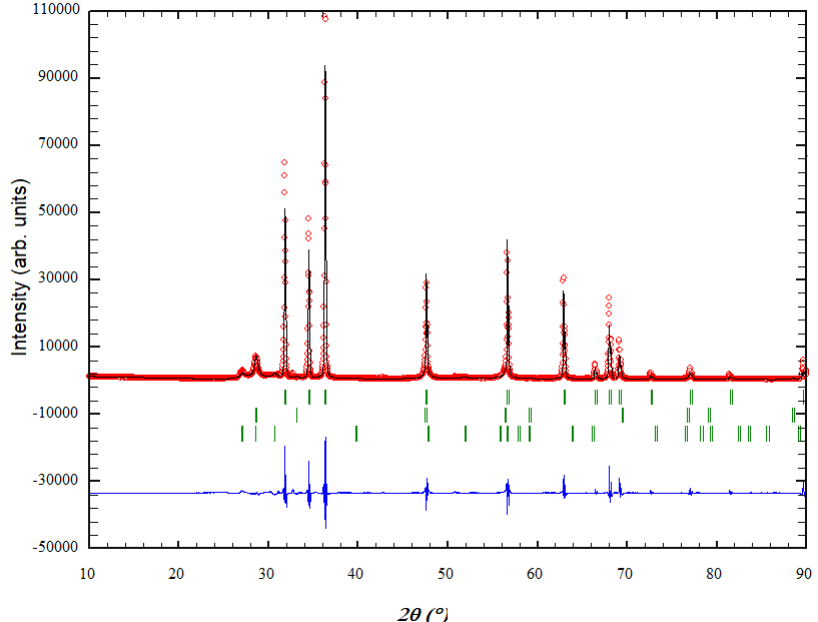
Figure 1. Rietveld diagram of ZnO/ZnS powders obtained after heating at 400 °C for 6 h. The blue line denotes the difference between the experimental (red diamonds) and theoretical (black line) profile, while the Bragg positions are indicated by vertical green slashes. The first, second, and third rows of green bars correspond to the diffraction lines of the ZnO wurtzite (2H) phase, the ZnS sphalerite (3C) phase, and the ZnS wurtzite (2H) phase, respectively.